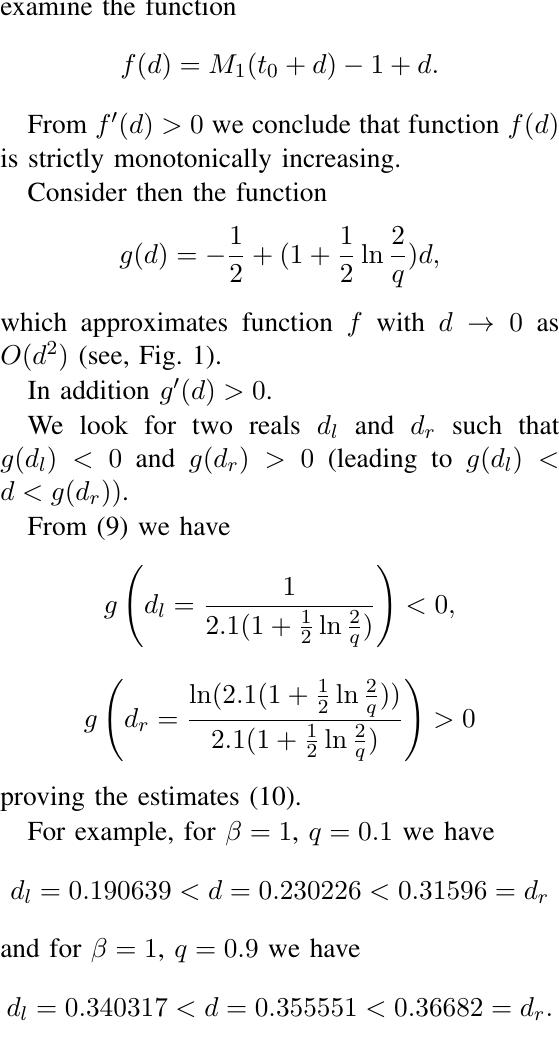
Fig. 2. a) β = 1 , q = 0 . 1 ; t 0 = 0 . 263156 ; Hausdorff distance d = 0 . 230226 ; b) β = 2 , q = 0 . 1 ; t 0 = 0 . 512988 ; Hausdorff distance d = 0 . 208046 ; c) β = 3 , q = 0 . 1 ; t 0 = 0 . 640823 ; Hausdorff distance d = 0 . 181048 ; d) β = 6 , q = 0 . 1 ; t 0 = 0 . 800514 ; Hausdorff distance d = 0 . 127635